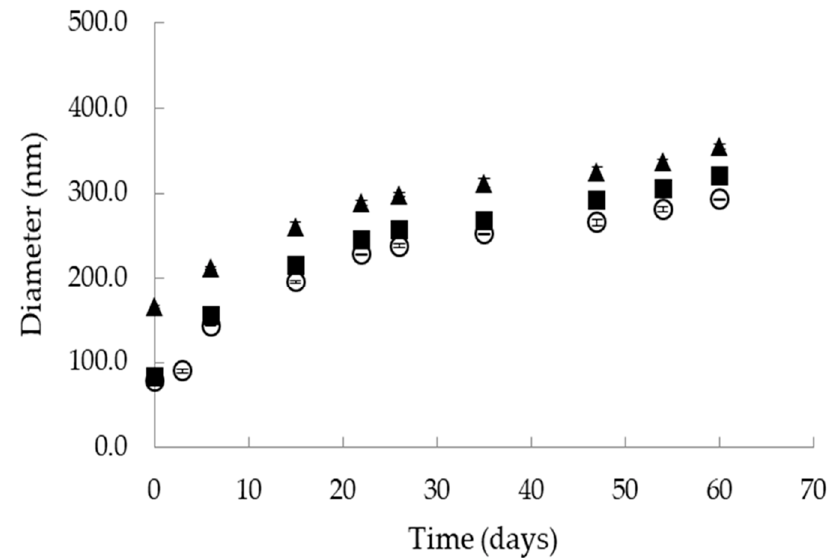
Figure 3. Storage stability of o / w nanoemulsions based on water, IPM, Tween 80, Labrasol, Maisine and Transcutol (L1). ( ○ ): empty, ( ■ ): loaded with vitamin D 3 , (